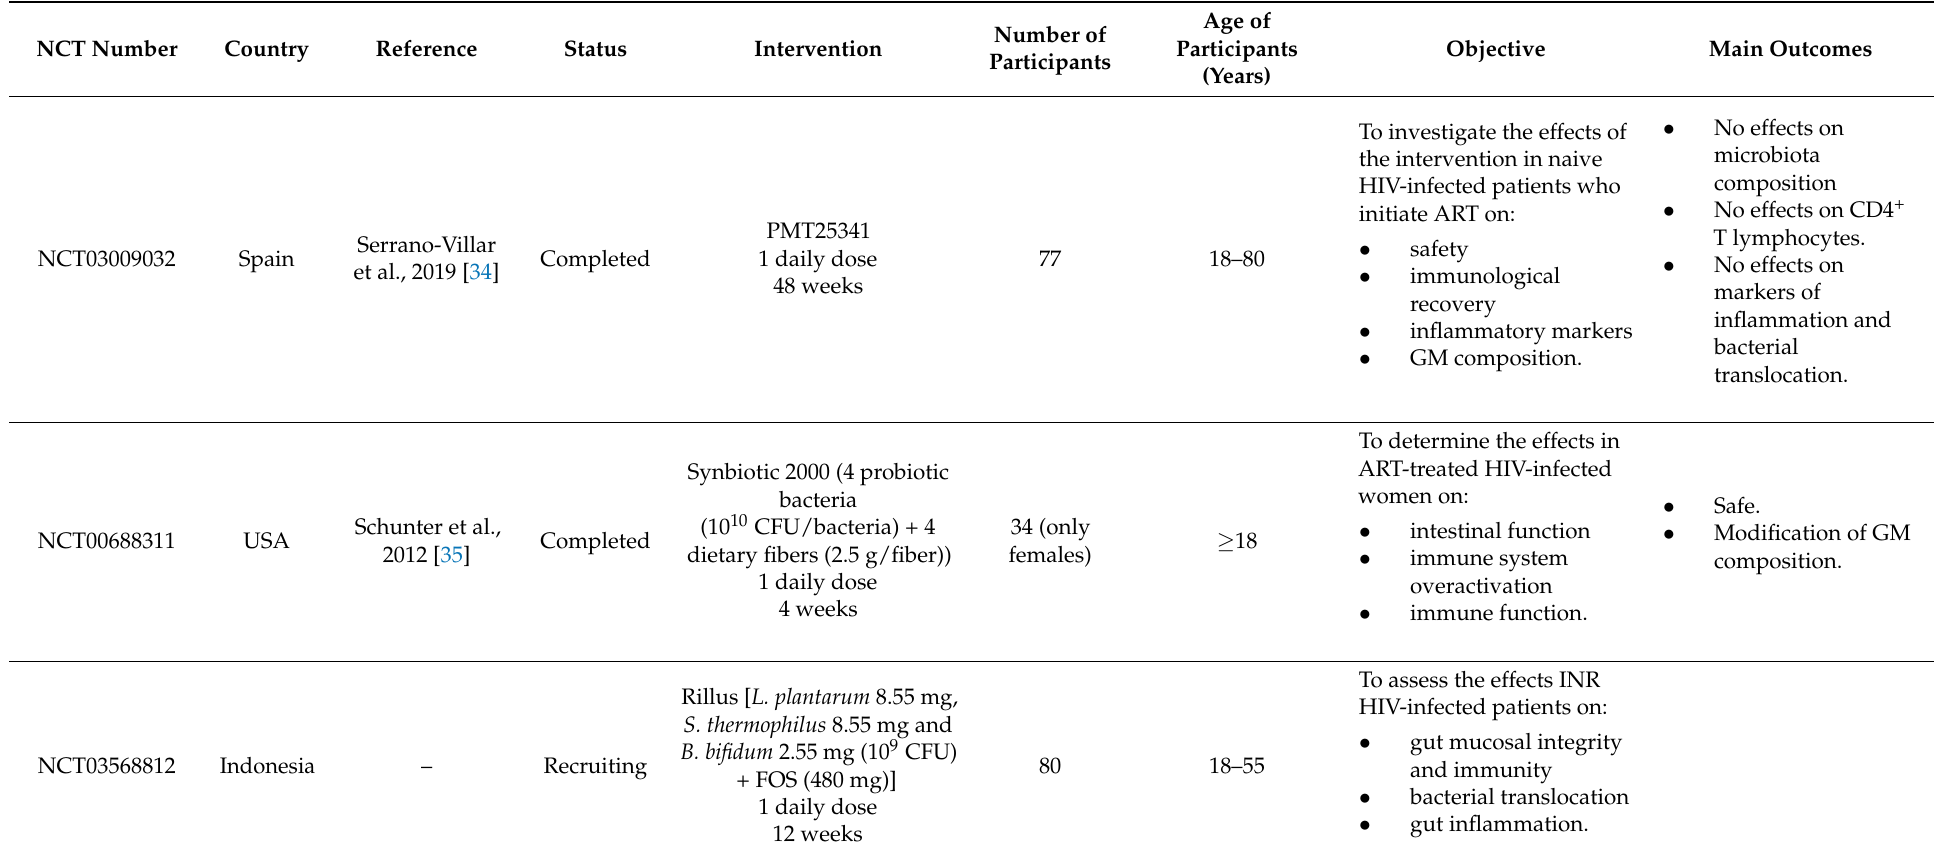
Table 3. Clinical trials concerning symbiotics registered in ClinicalTrials.gov